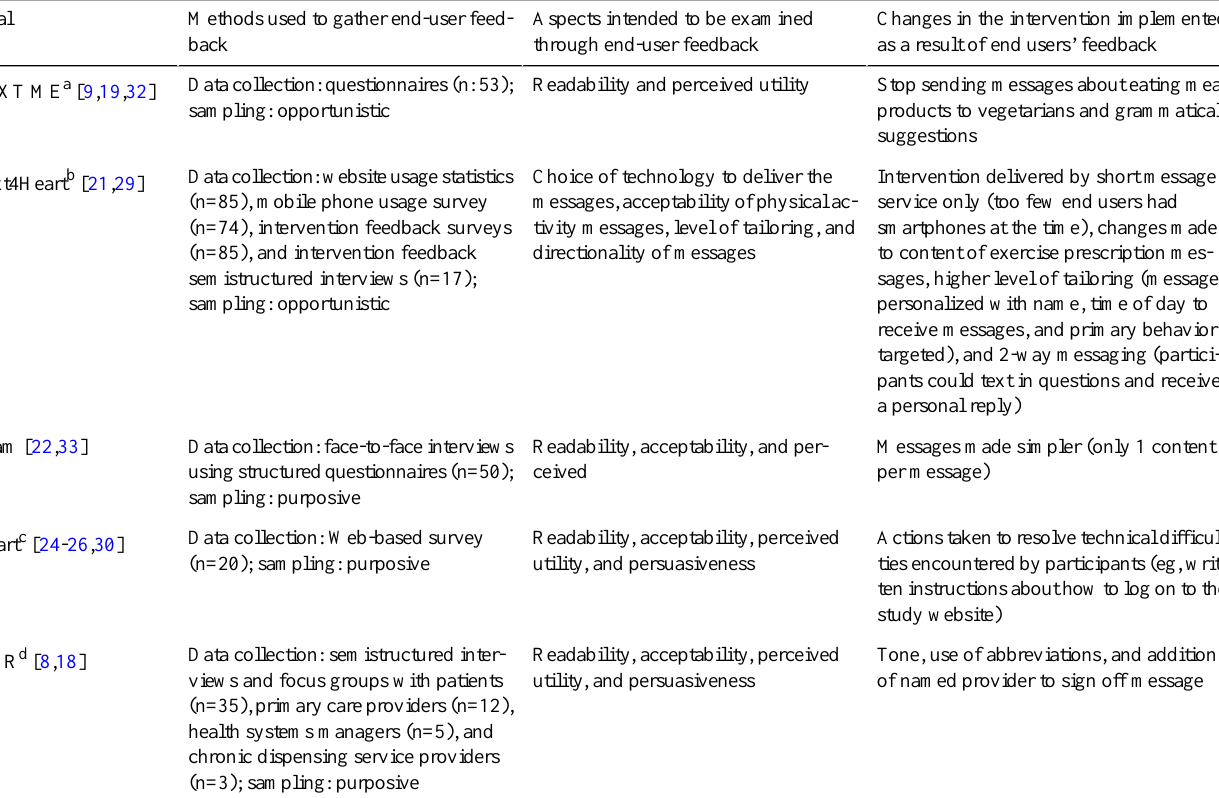
Table 3. Intervention development: end-user feedback.